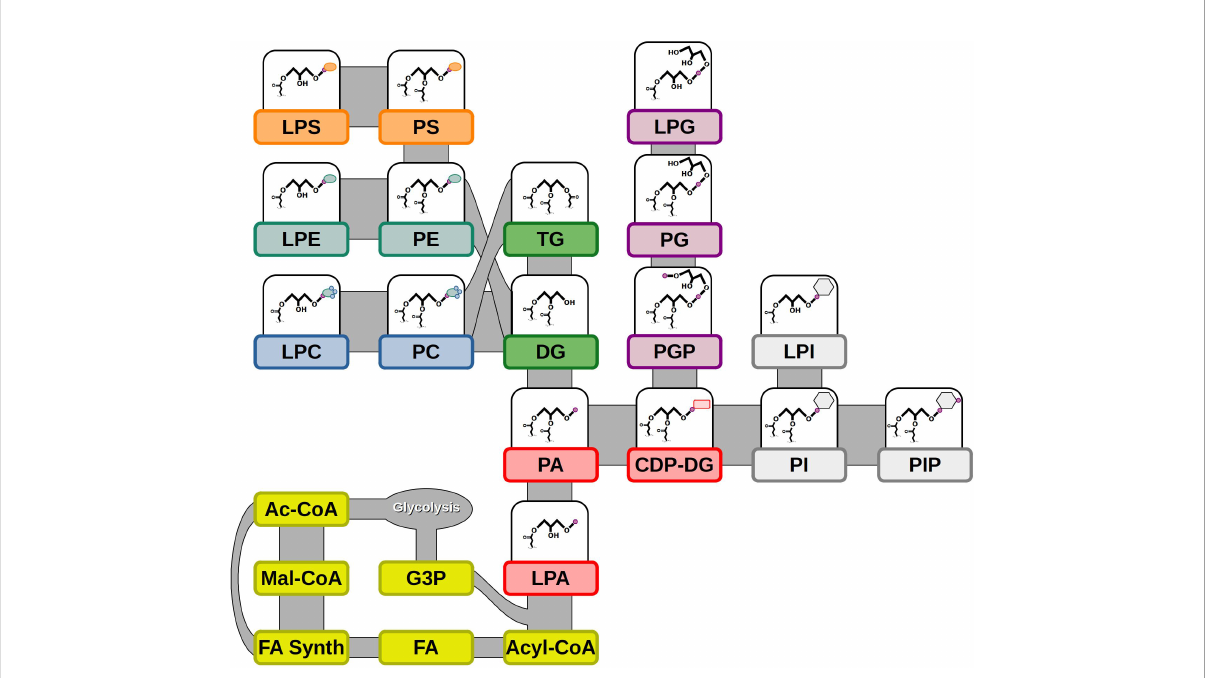
FIGURE 1 Lipid biosynthesis and molecular diversity. Lipid synthesis begins with precursors from glycolysis: Ac-CoA & G3P. FAs produced from FA synthesis are made into Acyl-CoA and added to G3P to synthesize LPA. Additional acylation and subsequent phospho headgroup addition leads to other lipid classes. Abbreviations – Ac-CoA, acetyl-Coenzyme A; CDP-DG, cytidine diphosphate diacylglycerol; DG, diacylglycerol; FA, fatty acid; FA Synth, fatty acid synthesis; G3P, glycerol-3-phosphate; LPA, lysophosphatidic acid; LPC, lysophosphatidylcholine; LPE, lysophosphatidylethanolamine; LPG, lysophosphatidylglycerol; LPI, lysophosphatidylinositol; LPS, lysophosphatidylserine; Mal-CoA, malonyl- Coenzyme A; PA, phosphatidic acid; PC, phosphatidylcholine; PE, phosphatidylethanolamine; PG, phosphatidylglycerol; PGP, phosphatidylglycerol phosphate; PI, phosphatidylinositol; PIP, phosphatidylinositol-phosphate; PS, phosphatidylserine; TG, triacylglycerol. Shapes – small purple circle, phosphate; rounded red rectangle, CDP; gray hexagon, inositol; light green oval, ethanolamine; small blue circle, methyl group; orange oval,